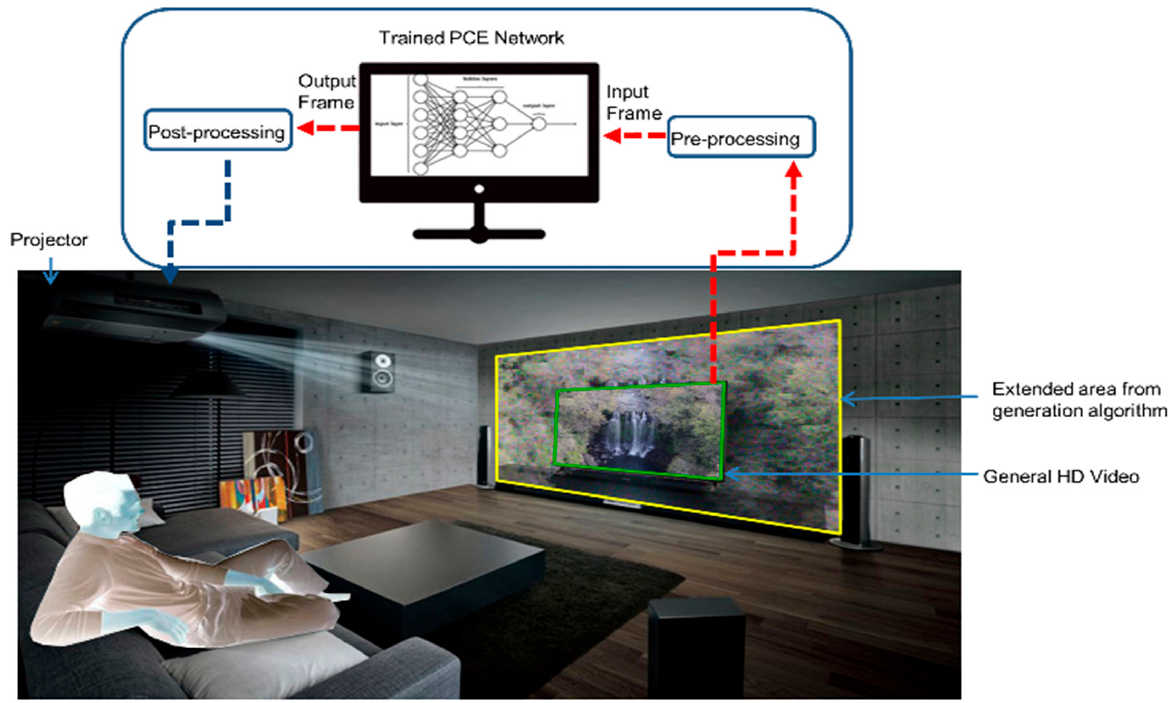
Figure 1. Overview of the proposed peripheral system and its interaction with the user.